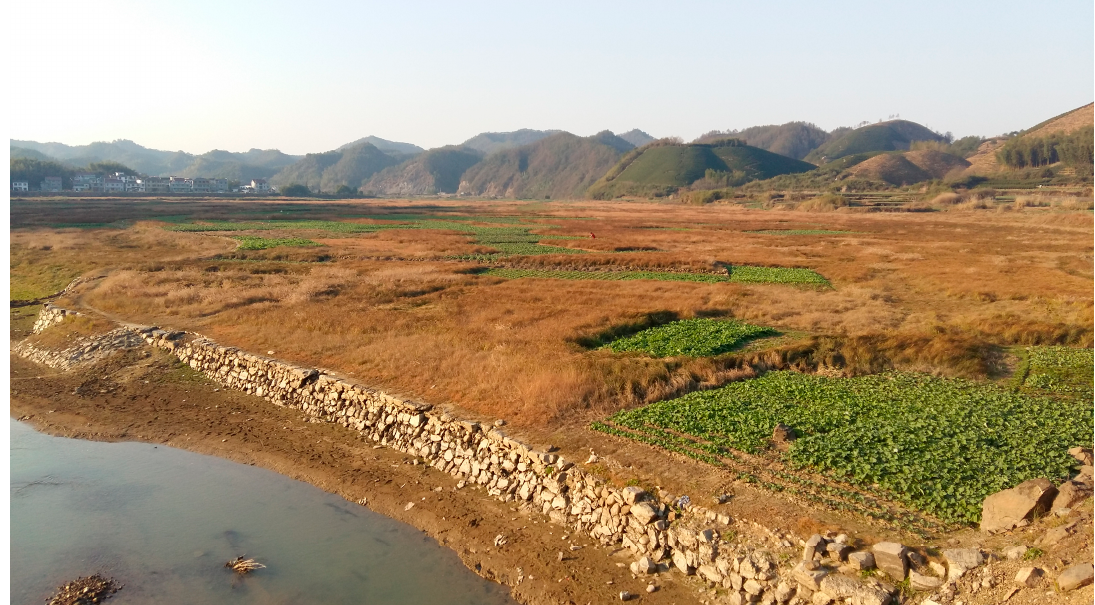
Figure 4. The intrusion of small scale agriculture onto an ecological buffer zone near an inlet to Qiandao Lake.